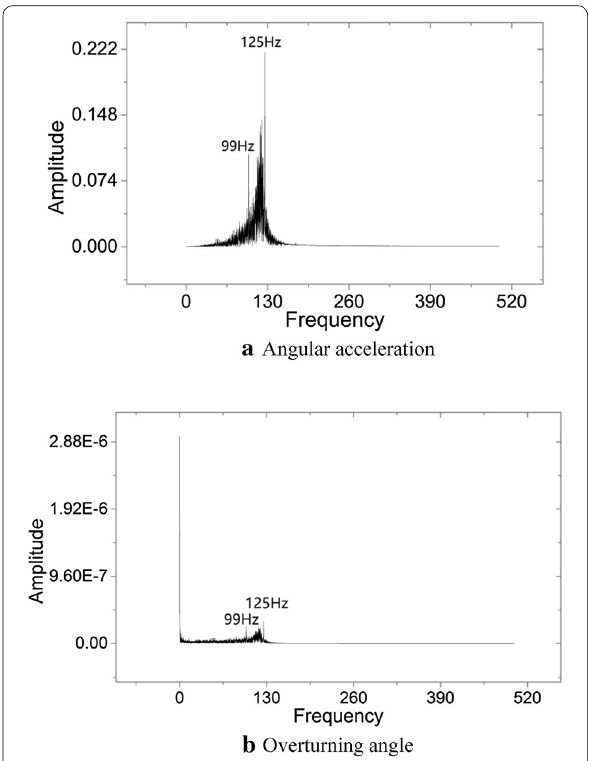
Figure 10 Frequency spectrum results in the overturning direction